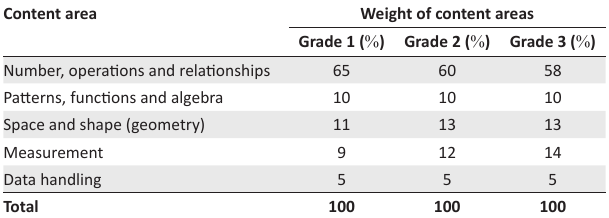
TABLE 1: Extracted from Foundation Phase Curriculum Assessment Policy Statement document. Content area Weight of content